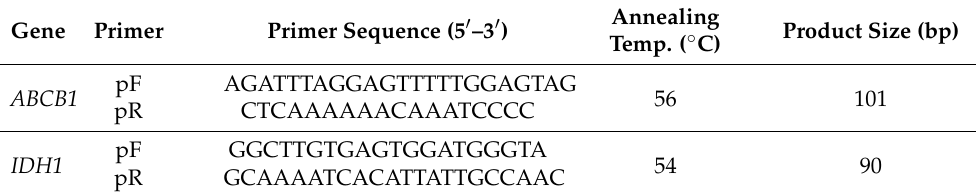
Table 1. Primer sequences—with their annealing temperature and amplicon size—for MS-HRM of ABCB1 , and genotyping of IDH1 . Primer reverse for IDH1 genotyping was also used as a sequencing primer during Sanger